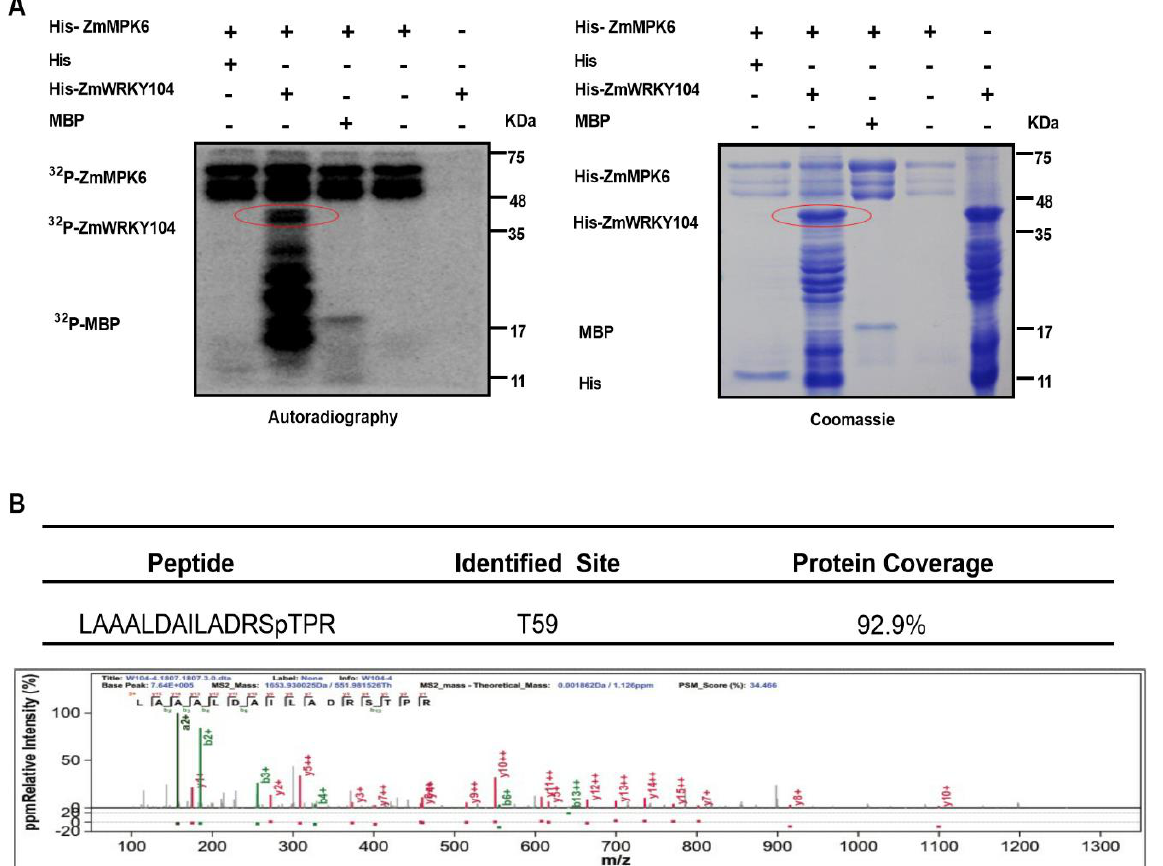
Figure 5. ZmMPK6 phosphorylates ZmWRKY104 in vitro. ( A ) ZmWRKY104 can be phosphorylated by ZmMPK6 in vitro. His−ZmMPK6, His−ZmWRKY104, and His proteins were expressed in E . coli . In vitro kinase assays were performed using the purified proteins. The substrate of His−ZmWRKY104 or maltose binding protein (MBP) was used for an in−gel kinase assay. Images show autoradiography (left panel) and the corresponding Coomassie staining (right panel). Molecular mass markers in kilodaltons are shown on the right. Experiments were repeated at least three times with similar results. ( B ) Phosphorylation site(s) analysis of ZmWRKY104 by LC−MS/MS.